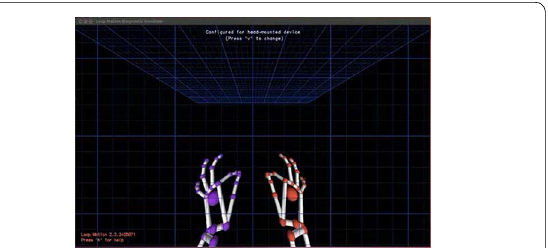
Fig. 6 Snapshot of the Diagnostic Visualizer software of the Leap Motion